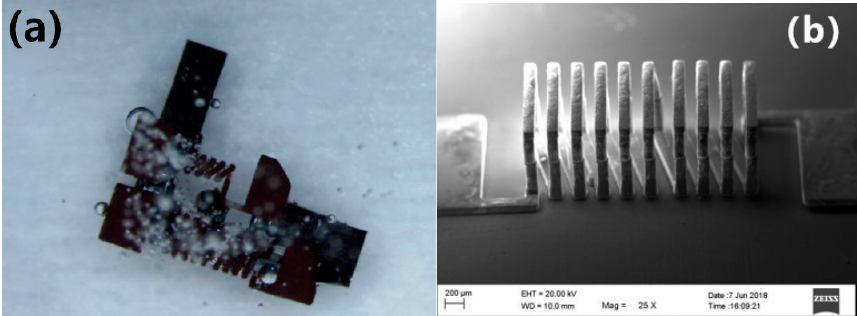
Figure 11. ( a ) 3D hollow inductor in tetramethylammonium hydroxide (TMAH) solution photographed by peripheral microscopy and ( b ) the hollow inductor after silicon removed, as photographed by SEM.